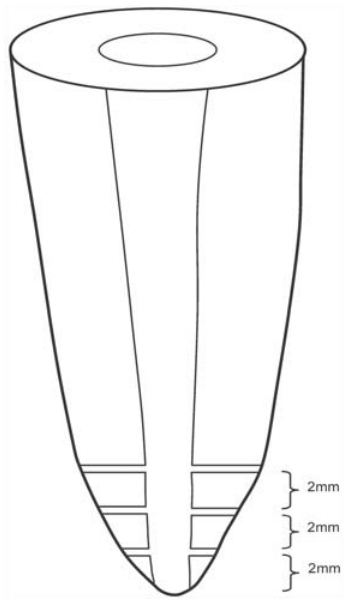
FIGURE 1 - Preparation of the artificial lateral